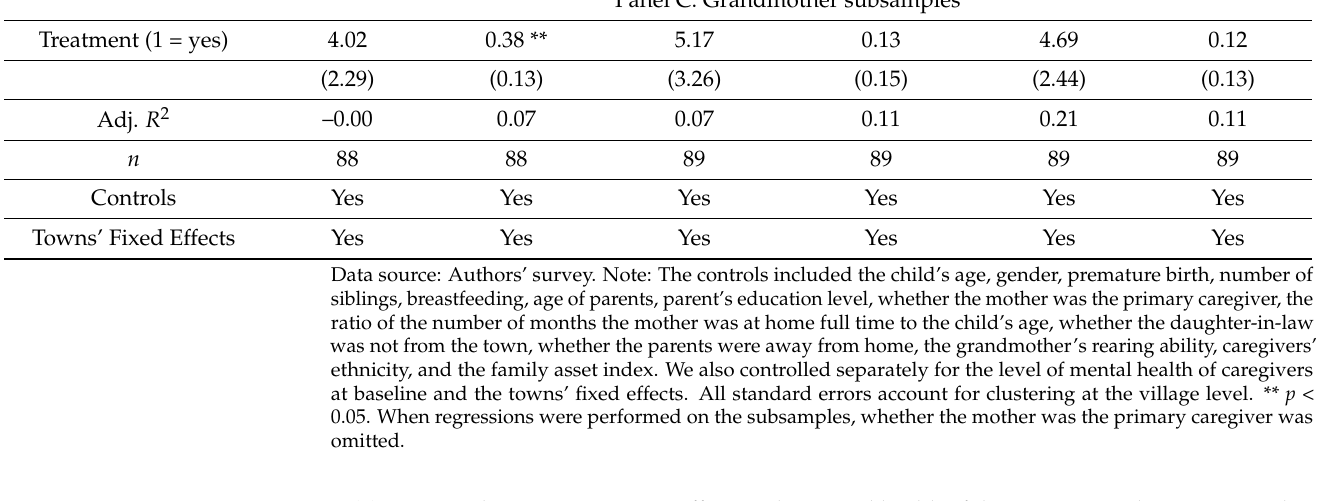
Table A3. Local average treatment effect on the mental health of the caregivers who participated in home visiting activities 22 times or